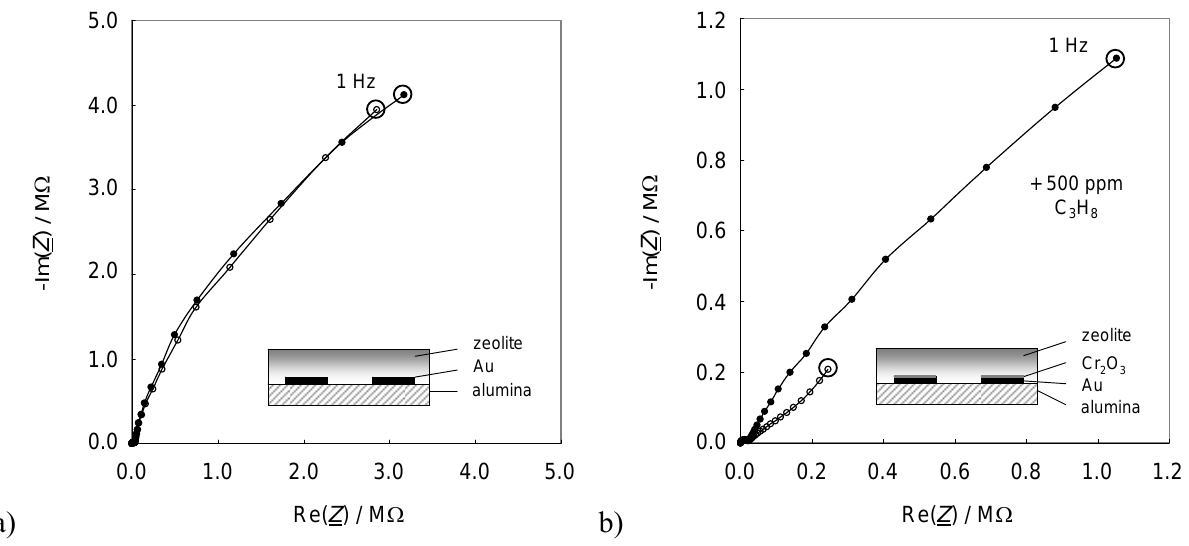
O and 2 O interfacial 2 3